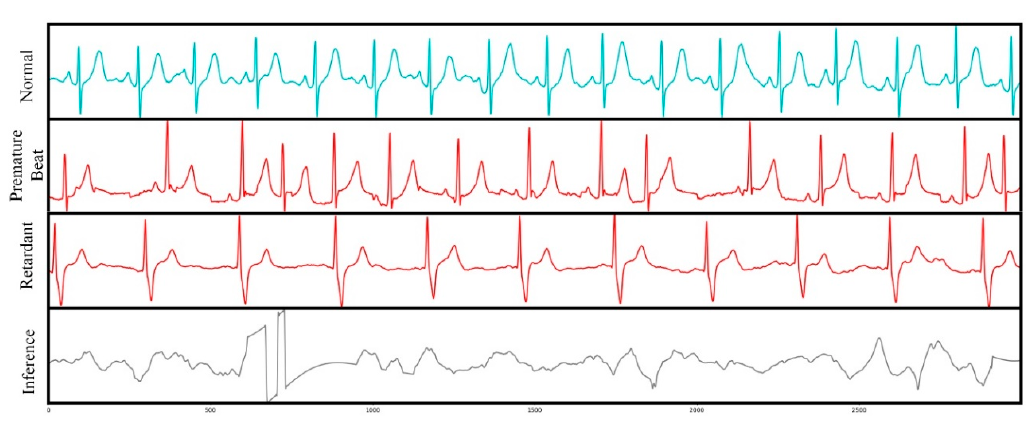
Figure 5. Four categories of ECG records in the dataset.